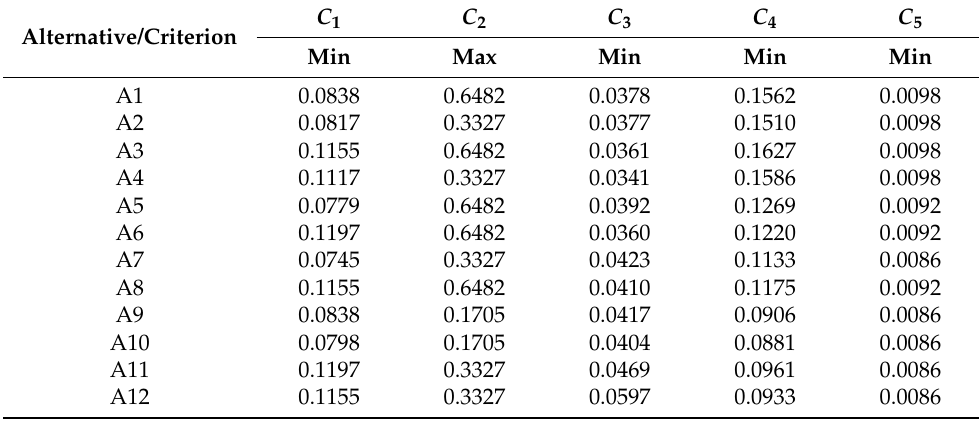
Table 12. Weighted normalized decision